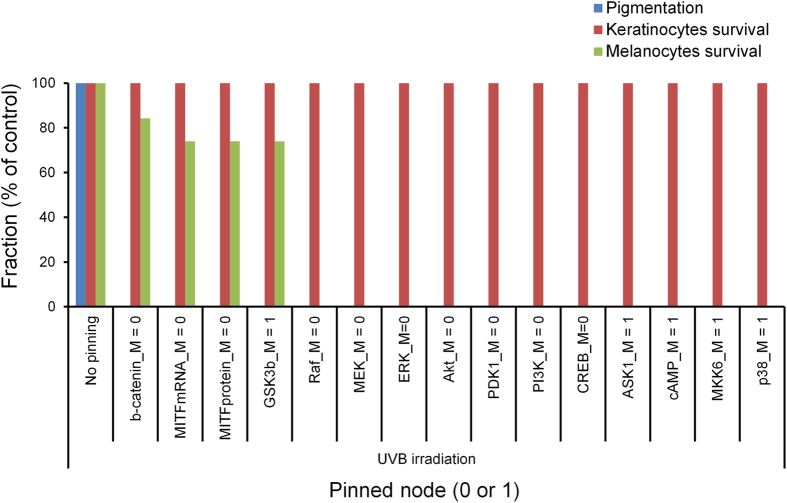
Network behavior in response to potentially effective target strategies under UVB irradiation. Fraction of initial states evolving into pigmentation, keratinocytes survival, or melanocytes survival attractors (phenotypes) in response to potentially effective target strategies under UVB irradiation.